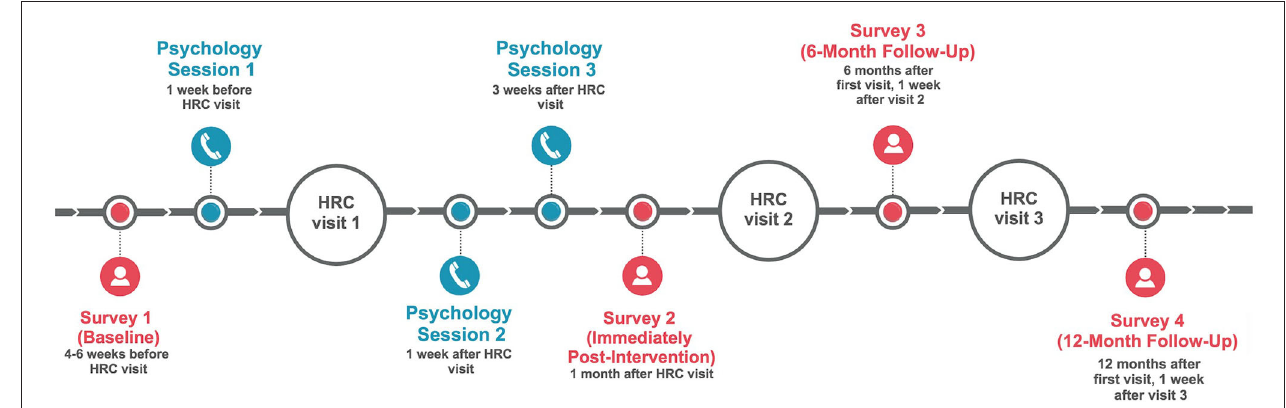
FIGURE 2 | Schedule and timing of individual psychology telephone sessions and study survey assessments. HRC, High Risk